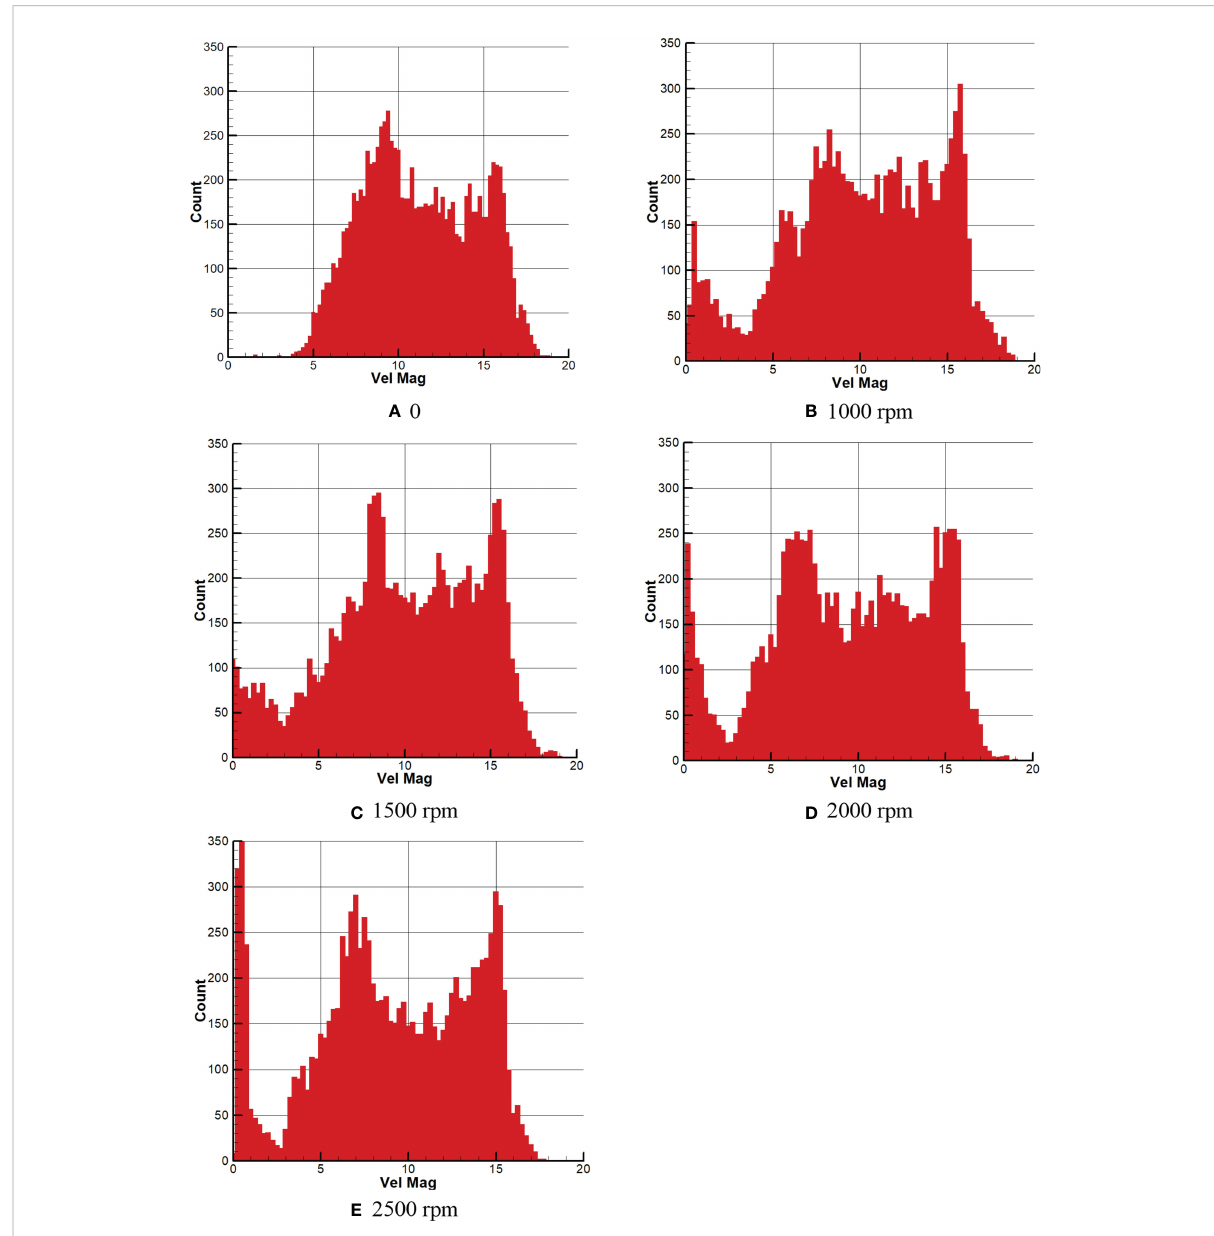
FIGURE 13 Quantitative distribution of average droplet velocity at different rotor